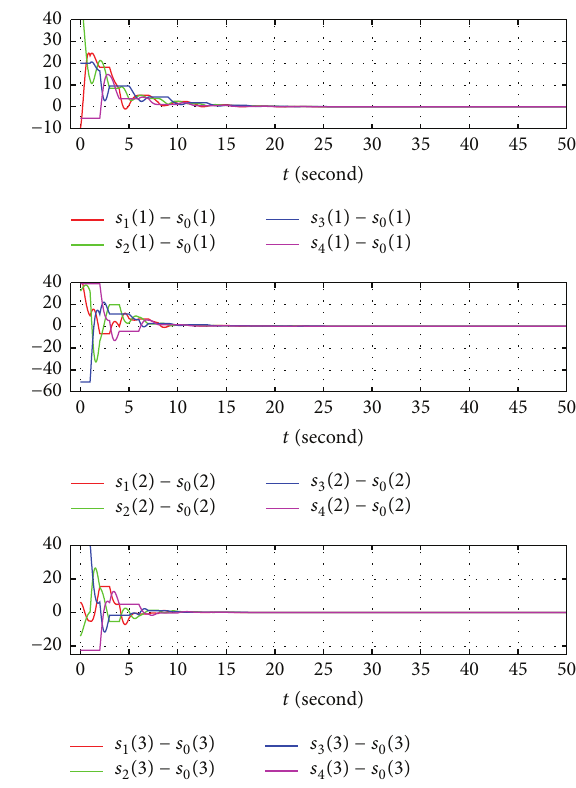
Figure 2: The attitude error 𝜎 𝑖 − 𝜎 0 .